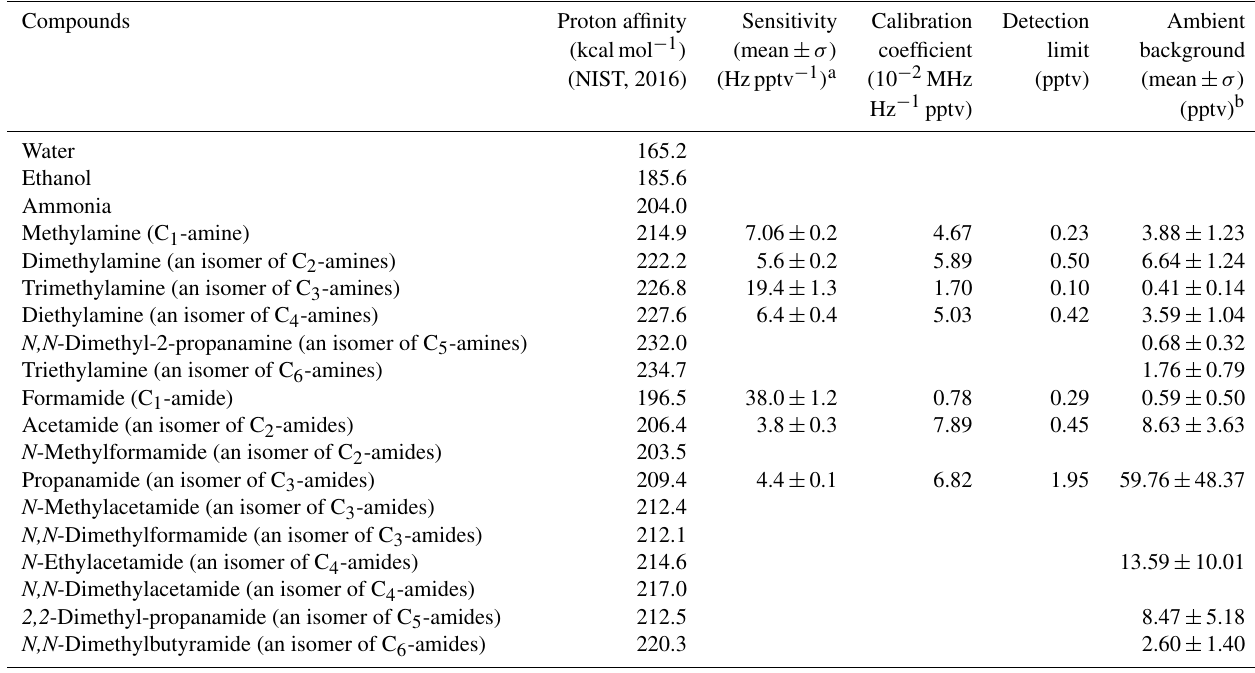
Table 1. Proton affinity, sensitivity, calibration coefficient, 1min detection limit at 3 σ of background signal during the laboratory characteri- zation, and ambient background of selected amines and